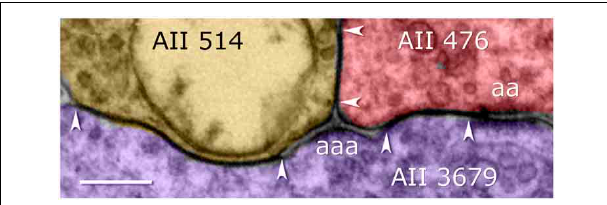
FIGURE 6 | Coupling among arboreal processes of AII cells in the Viking connectome viewer. Contiguous gap junctions between arrowheads range 200–500nm in extent. All gap junctions are accompanied by dual (aa) or triple (aaa) adherens junctions. Scale, 200nm.